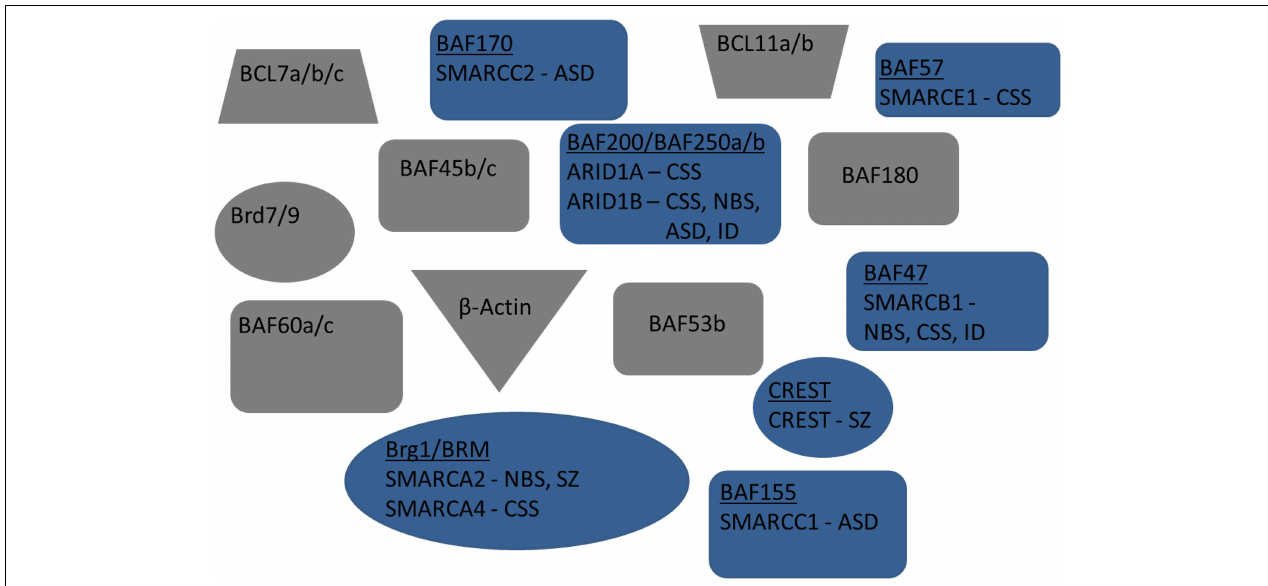
FIGURE 2 | Exploded view of nBAF complex. Mammalian subunits associated with neuro developmental and/or cognitive disorders are in blue. Human gene name is also included below subunit name. Mammalian subunits in gray have no currently known mutations linked with new:odevelopment or adult